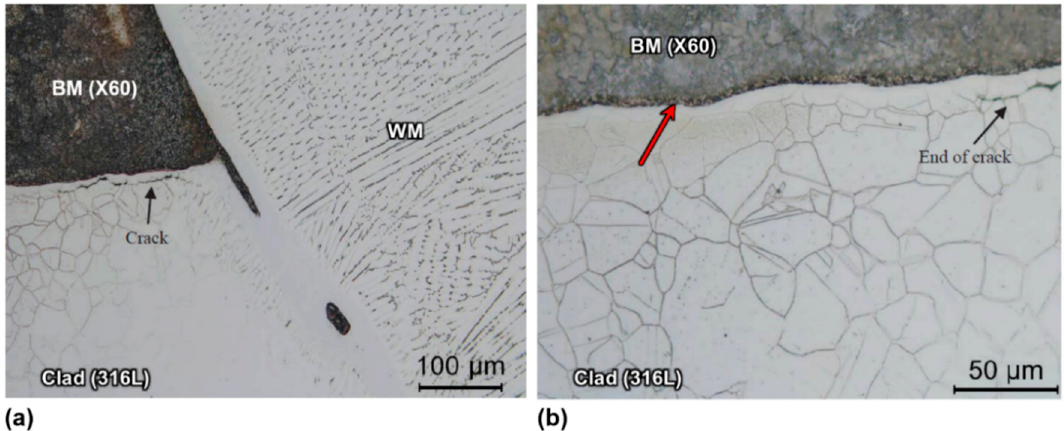
Figure 19. ( a ) Cracking near the bimetallic interface in the clad and ( b ) grain boundary precipitates, as indicated by the red arrow, near the interface [21].